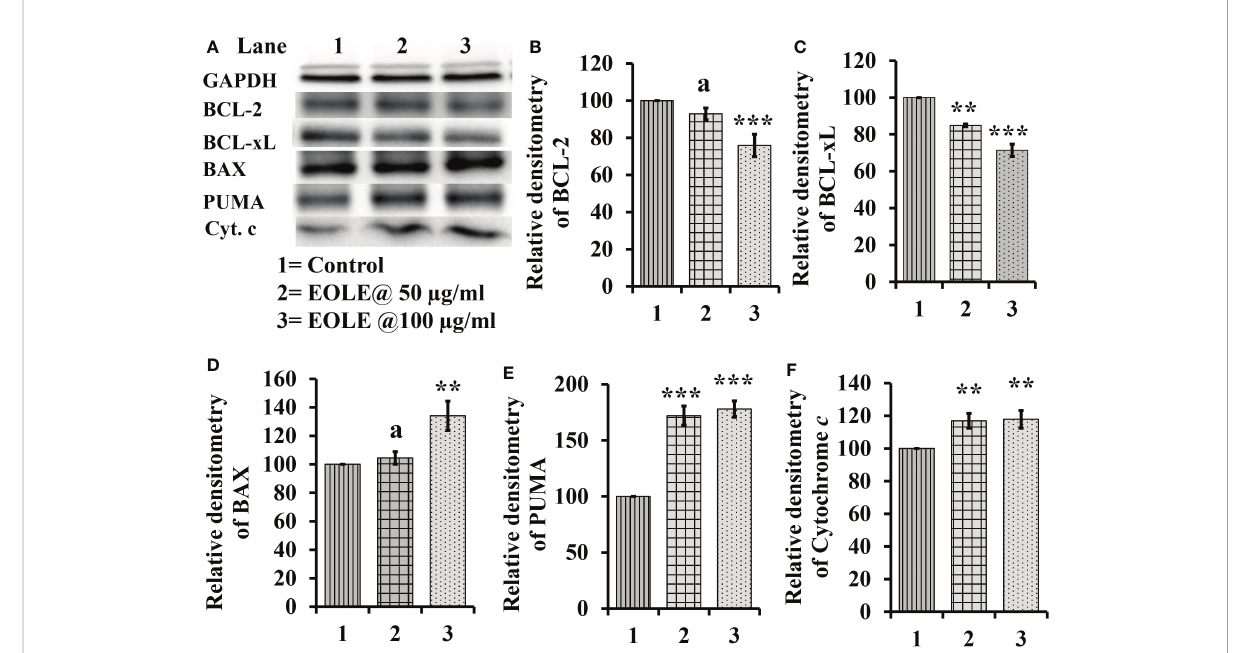
FIGURE 2 Figure showing the expression of many apoptotic pathway proteins in control and EOLE treated K562 cells, where (A) Images of protein bands, (B) Densitometry plot for BCL-2, (C) Densitometry plot for BCL-xL, (D) Densitometry plot for BAX, (E) Densitometry plot for PUMA, (F) Densitometry plot for cytochrome c Values are expressed as mean ± SD of 3 observations. The statistical signi fi cance was tested using one-way ANOVA following Tukey ’ s multiple comparison tests by comparing the values as, control vs . treatments. P-value, p<0.05 was considered as statistically signi fi cant and denoted as a= not signi fi cant when p > 0.05; * when p < 0.05; ** when p < 0.01; and *** when p <